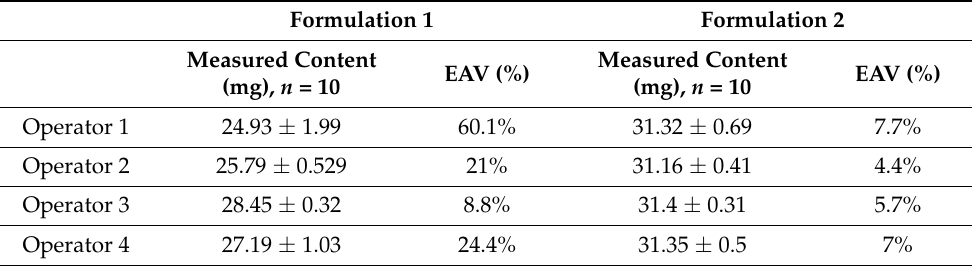
Table 4. Uniformity of dosage results from the suppositories prepared by inexperienced opera- tors. EAV: experimental acceptance value (target: <15%). n = 10, values expressed as mean ± standard